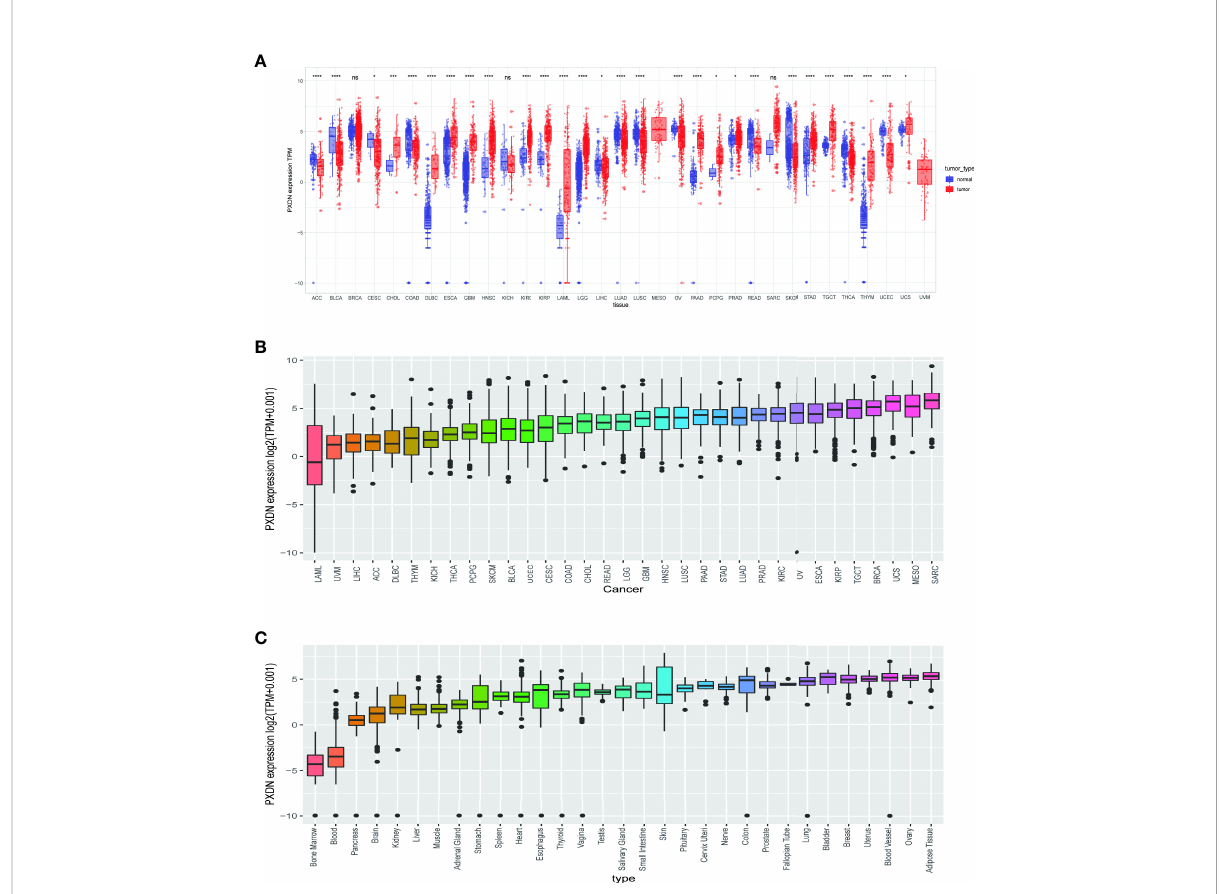
FIGURE 1 Expression of PXDN gene in different tumours and normal tissues. The results are based on data collated from the TCGA and GTEx databases. (A) Analysis of differential expression of PXDN in tumor tissues and normal tissues. *p < 0.05, ***p < 0.001, ****p < 0.0001. (B) The differences of the PXDN expression increased from left to right in each of the 33 tumors. (C) The differences of the PXDN expression increased from left to right in each of the 31 normal tissues. ns, no signi fi